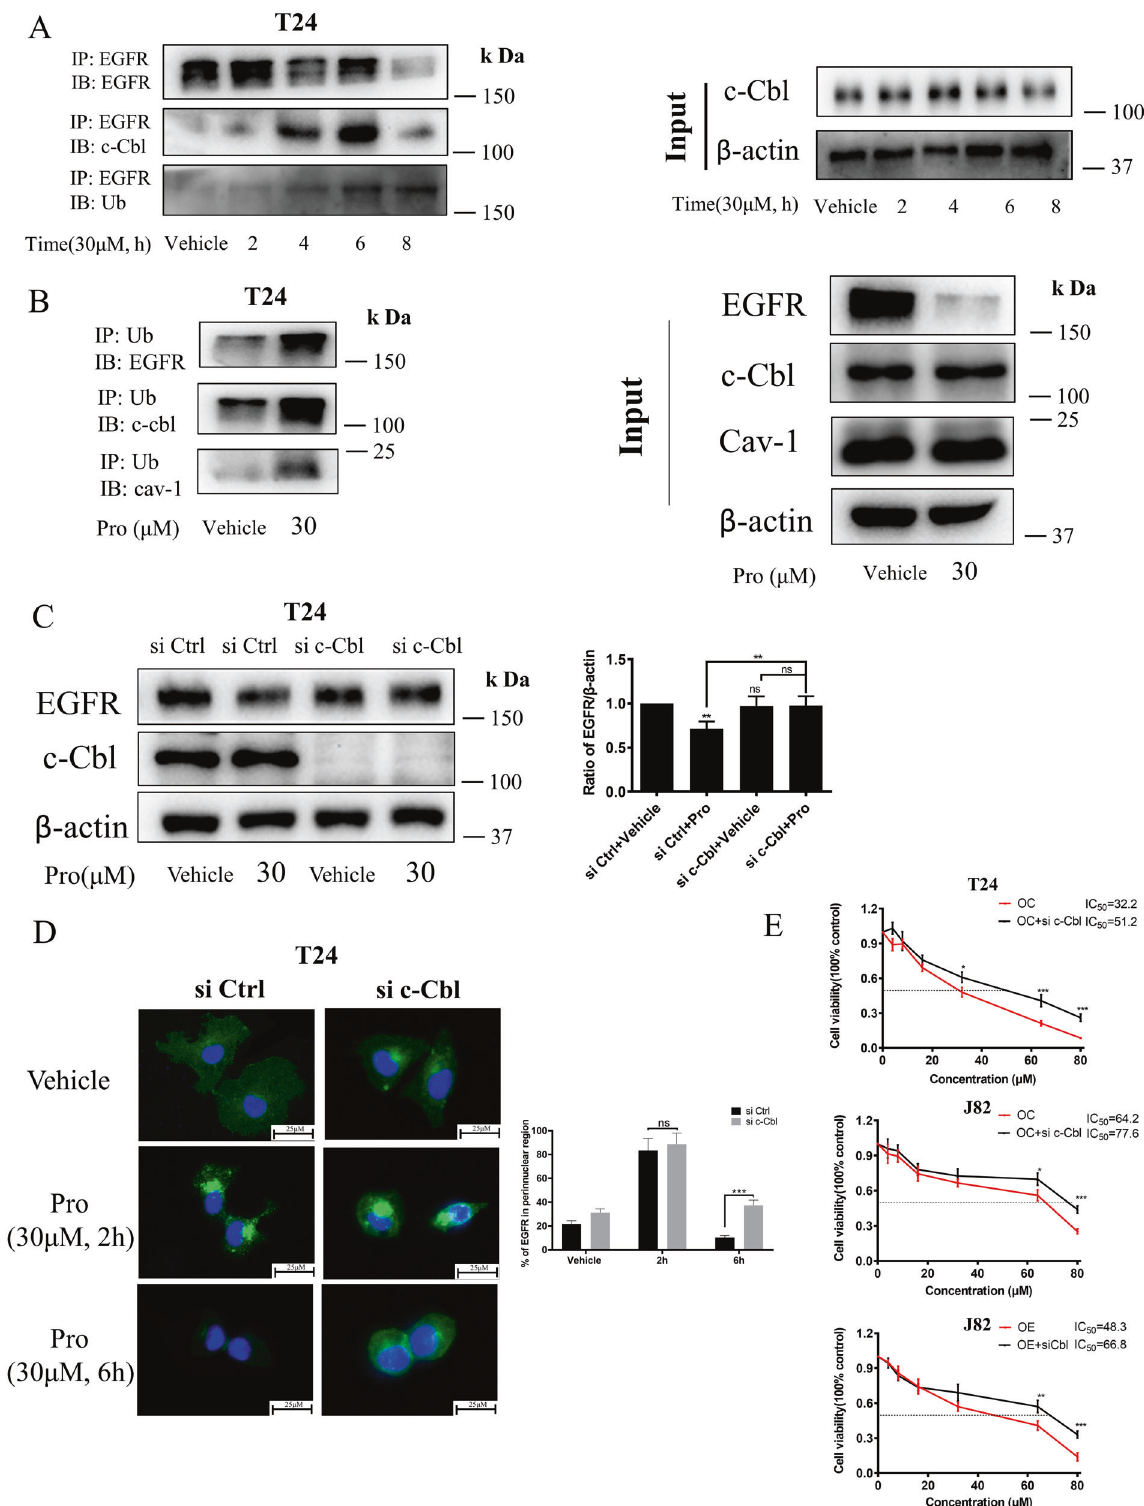
of Ki-67 positive cells in tumor tissues was increased in the presence of autophagy inhibitor, 3-MA in proguanil-treated group compared with proguanil treatment alone (SFig. 4D). In addition, LC3 immunohistochemistry further revealed that proguanil could up-regulate the expression of this autophagy biomarker